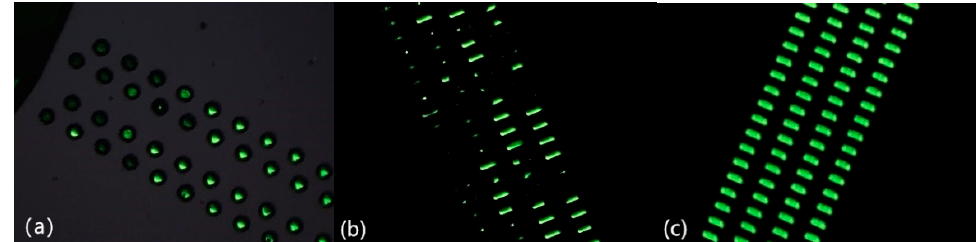
Figure 1. Results of three pretreatment methods observed through the dark field photographed with an optical microscope. ( a ) ultrasonic cleaning, ( b ) rinsing with deionized water, and ( c ) vacuum processing.